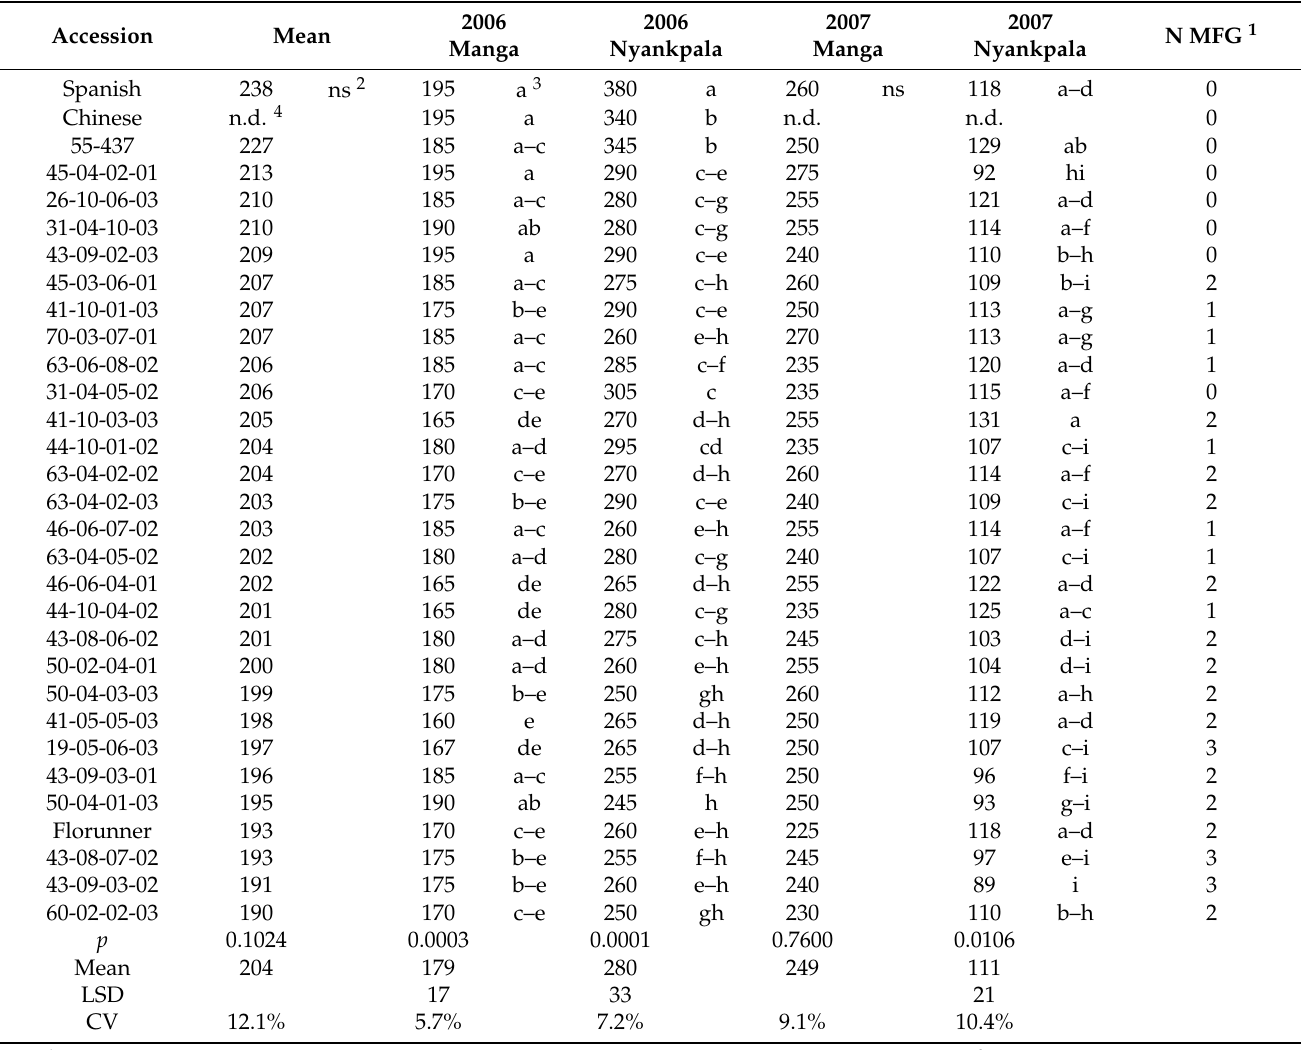
Table 2. Response of cultivars to late leaf spot. Values are AUDPC